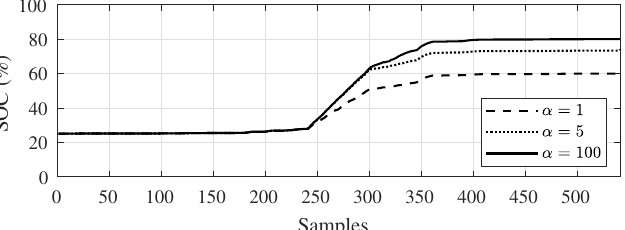
Figure 5. Evolution of the α weight applying different values for tuning, considering fixed unit value for γ and β